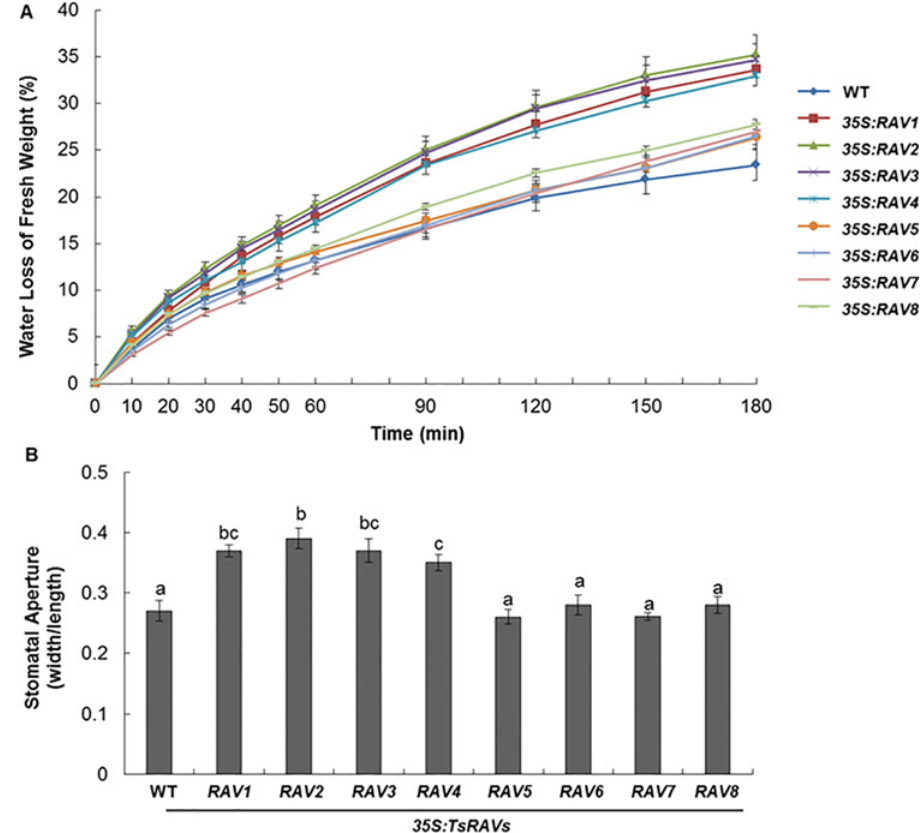
Fig 7. Different water loss rates of wild-type and 35S : TsRAVs transgenic Arabidopsis plants. (A) Weight loss in fresh leaves under water deficit of 4-week-old wild-type and 35S : TsRAVs transgenic Arabidopsis plants. Each data bar represents the mean ± SE of three replicates. (B) Width/length ratio of the rosette leaf stomatal aperture of 4-week-old wild-type and 35S : TsRAVs transgenic Arabidopsis plants. Each data bar represents the mean ± SE of three replicates and different letters indicate significant differences among means ( P < 0.05 by Tukey ’ s test).